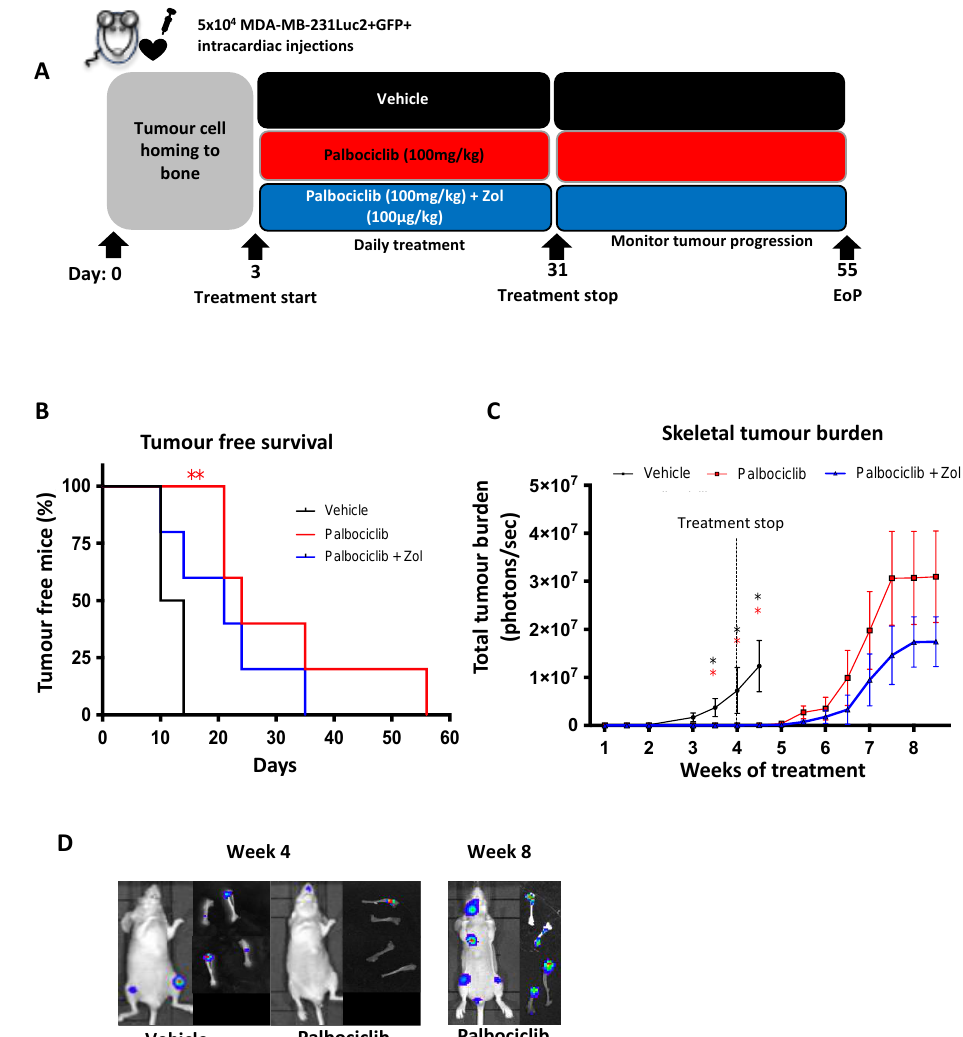
Figure 4. Continuous Palbociclib treatment inhibits tumour growth in bone which is not improved by zoledronic acid. ( A ) Schematic outline of the experiment. Mice were injected with 5 × 10 4 MDA- MB-231Luc2+GFP+ cells via the intracardiac route. Treatment with 100 mg/kg palbociclib or vehicle commenced on day 3 and continued daily for 28 consecutive days. A third group received palbociclib daily in addition to the anti-resorptive agent zoledronic acid (Zol) once a week (intraperitoneally). ( B ) Detection of skeletal tumours in vehicle and palbociclib ± Zol treated animals throughout the duration of the study ( n = 8 per group, (red) ** p < 0.005; Log-rank (Mantel–Cox) test vehicle vs. palbociclib). ( C ) Tumour progression as measured by tumour burden in response to vehicle or palbociclib ± Zol (Mean ± SEM n = 8 per group * p < 0.05). ( D ) Representative images of tumour progression at week 4 and week 8 in the live mouse and detected by ex vivo imaging of isolated hind limbs. EoP—End of procedure.